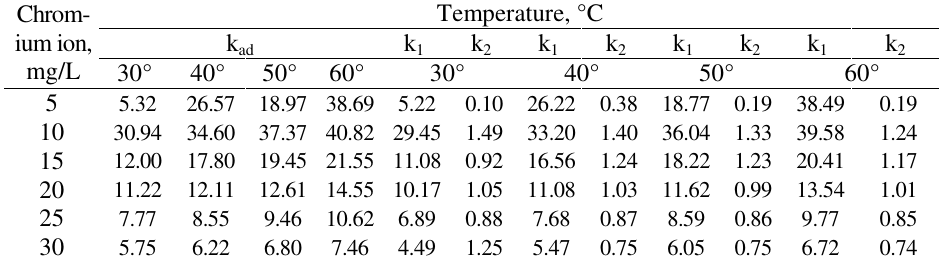
, min -1 ) and the constants ad